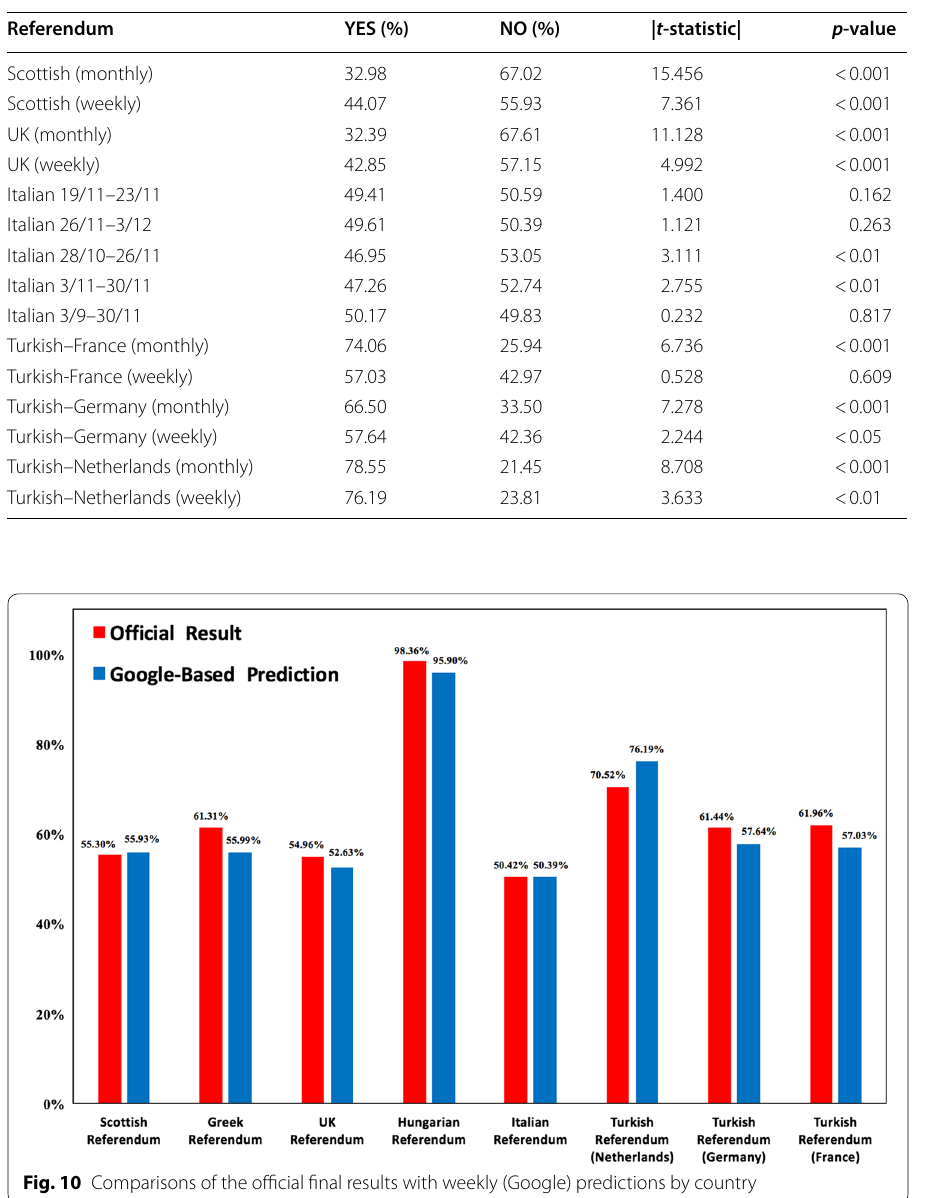
Fig. 10 Comparisons of the official final results with weekly (Google) predictions by